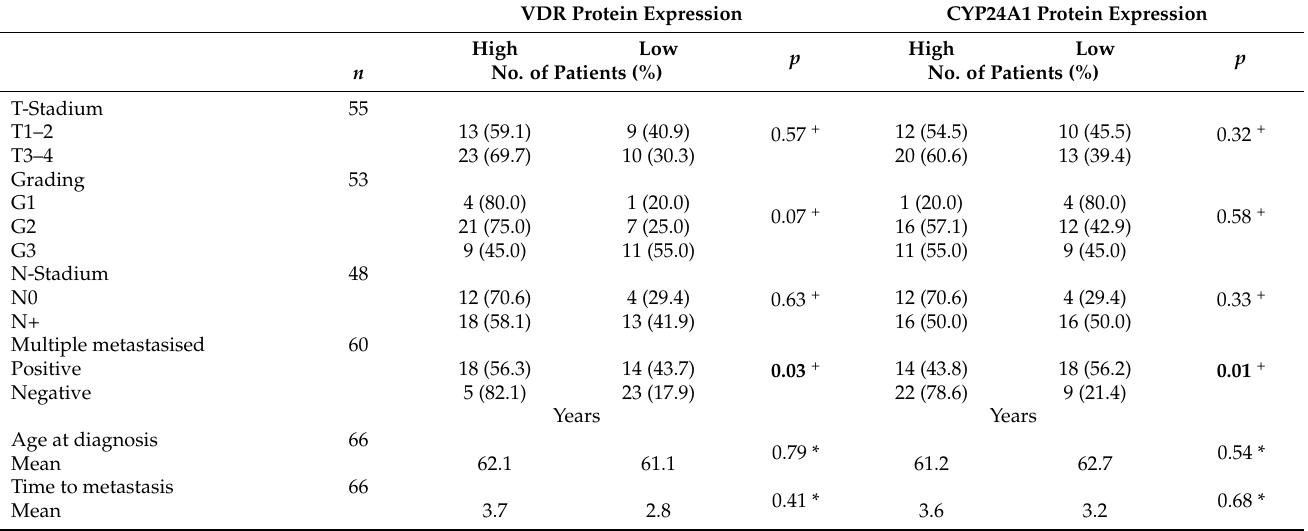
Table 2. Associations between VDR/CYP24A1 protein expression and clinicopathological charac- teristics. Abbreviations: VDR—vitamin D receptor; No./ n —number; *—Mann–Whitney U